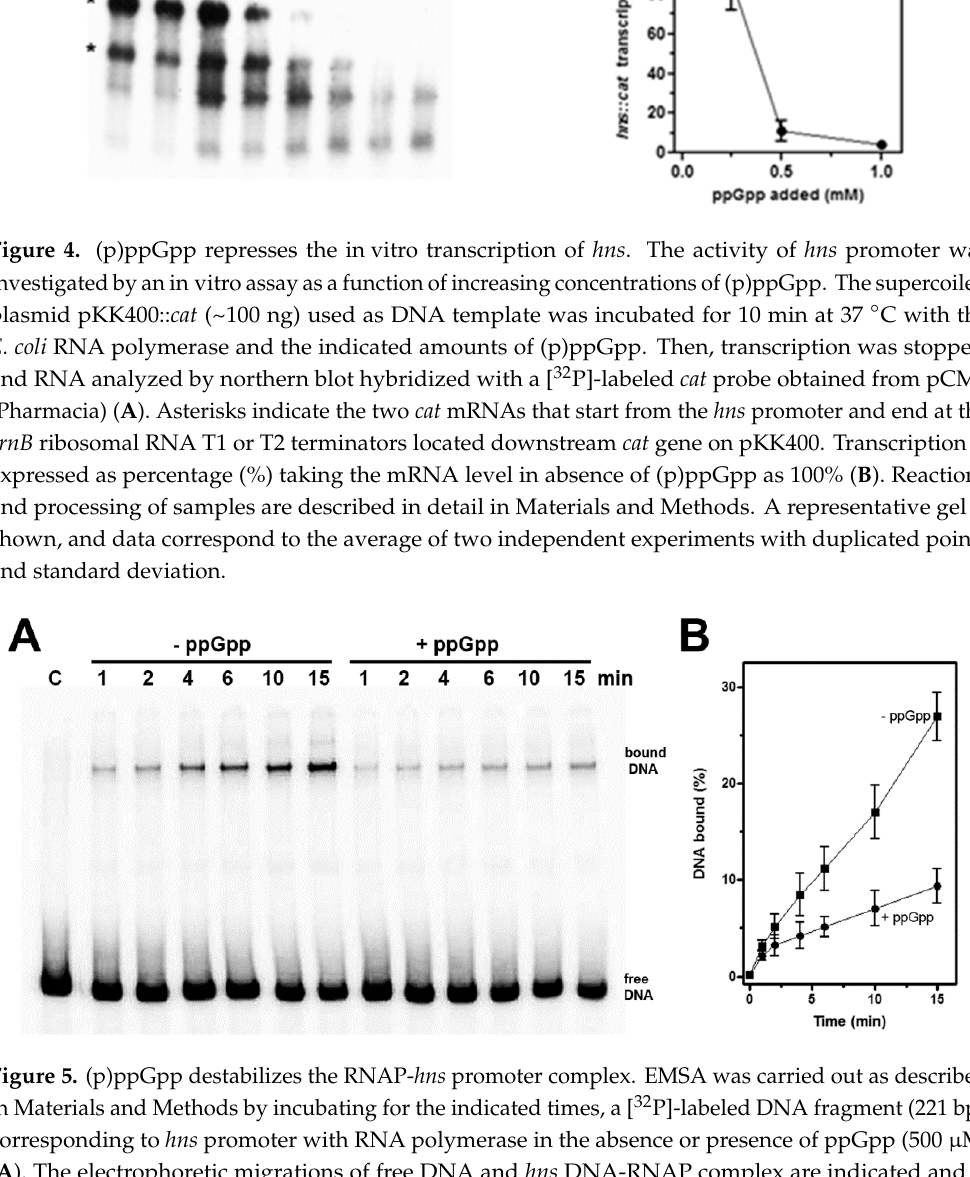
Figure 4. (p)ppGpp represses the in vitro transcription of hns . The activity of hns promoter was investigated by an in vitro assay as a function of increasing concentrations of (p)ppGpp. The supercoiled plasmid pKK400:: cat (~100 ng ) used as DNA template was incubated for 10 min at 37 °C with the E. coli RNA polymerase and the indicated amounts of (p)ppGpp. Then, transcription was stopped, and RNA analyzed by northern blot hybridized with a [ 32 P]-labeled cat probe obtained from pCM7 (Pharmacia) ( A ). Asterisks indicate the two cat mRNAs that start from the hns promoter and end at the rrnB ribosomal RNA T1 or T2 terminators located downstream cat gene on pKK400. Transcription is expressed as percentage (%) taking the mRNA level in absence of (p)ppGpp as 100% ( B ). Reactions and processing of samples are described in detail in Materials and Methods. A representative gel is shown, and data correspond to the average of two independent experiments with duplicated points and standard deviation.